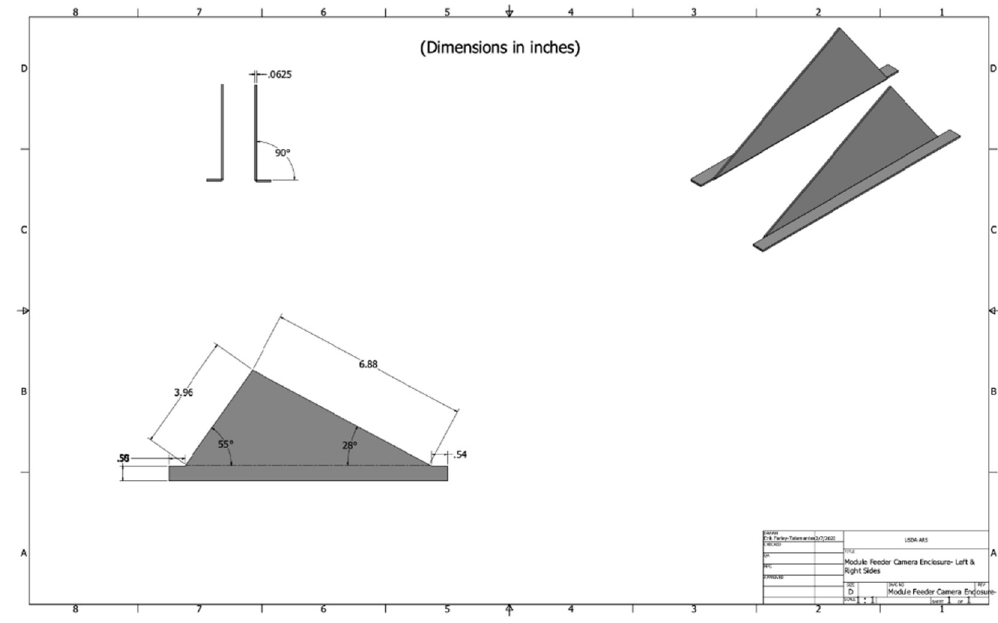
Figure 10. Module feeder camera housing support bracket (#1, 3 of assembly drawing).